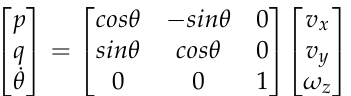
robot frame { x R , y R } . As the goal was to find the relative velocities of the wheel drives of the robots, the relation between the velocities in the global frame and the robot frame